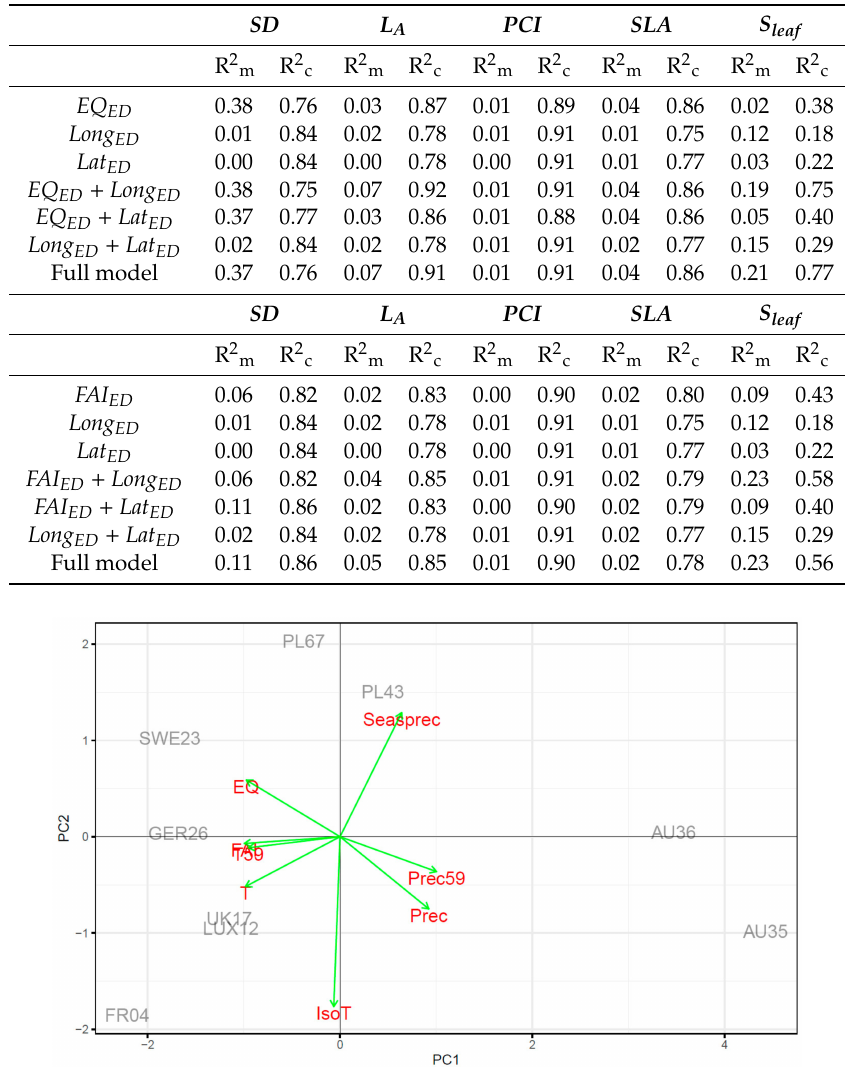
Table A3. Values of the marginal and conditional R 2 of mixed models presented in Table A2.